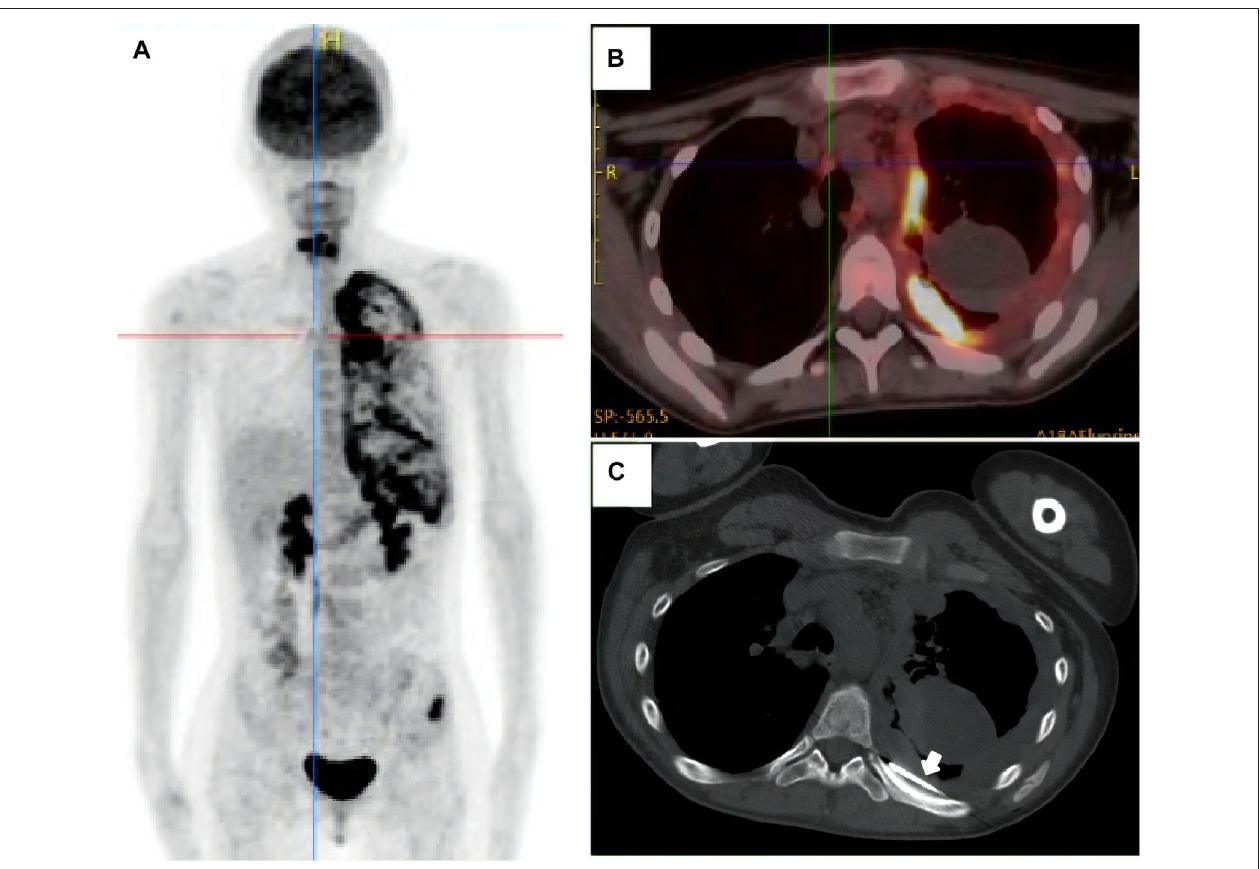
FIGURE2| Thepositronemissiontomography/computedtomographyscanshowedincreasedmetabolicactivityintheleftiliacbone,the6thcervicalvertebraand the whole left pleura (A, B) . The patient underwent CT-guided biopsy of the left pleural mass [ (C) , arrow].